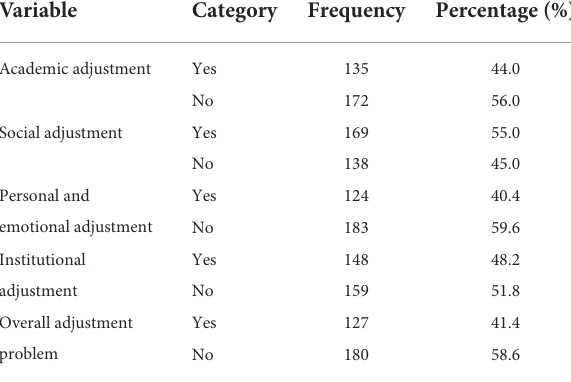
TABLE 3 Prevalence of adjustment problems among regular first-year undergraduates at Wollo University main campus, Dessie, Northeast, Ethiopia, 2020 ( n =